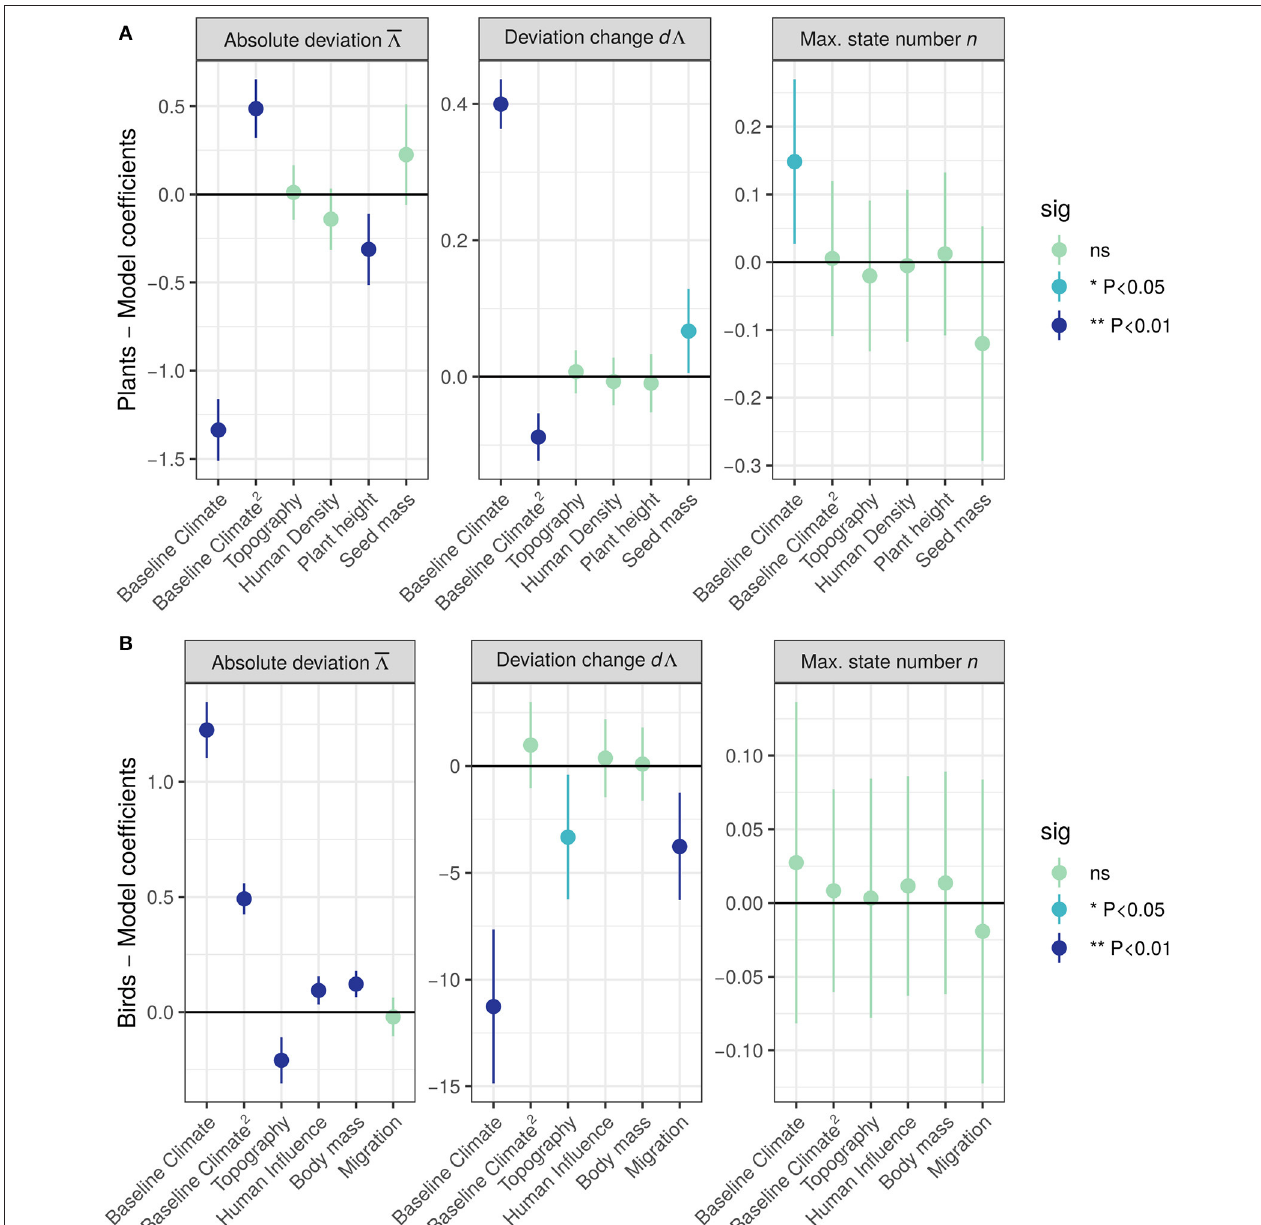
FIGURE 4 | Effect of predictors on plant (A) and bird (B) summary statistics (absolute deviation ¯ 3 , left panel; deviation change d 3 , middle panel, maximum state number n , right panel), estimated as linear coefficients ( ± 95% confidence intervals) from generalized additive mixed models. Topography and Human Density were square-root transformed. All predictors were scaled to mean = 0 and SD = 1 prior to modeling to ease comparisons. Point and bar colors indicate the significance level associated to the test (light green: non-significant; light blue: significant at α = 5%; dark blue: significant at α =